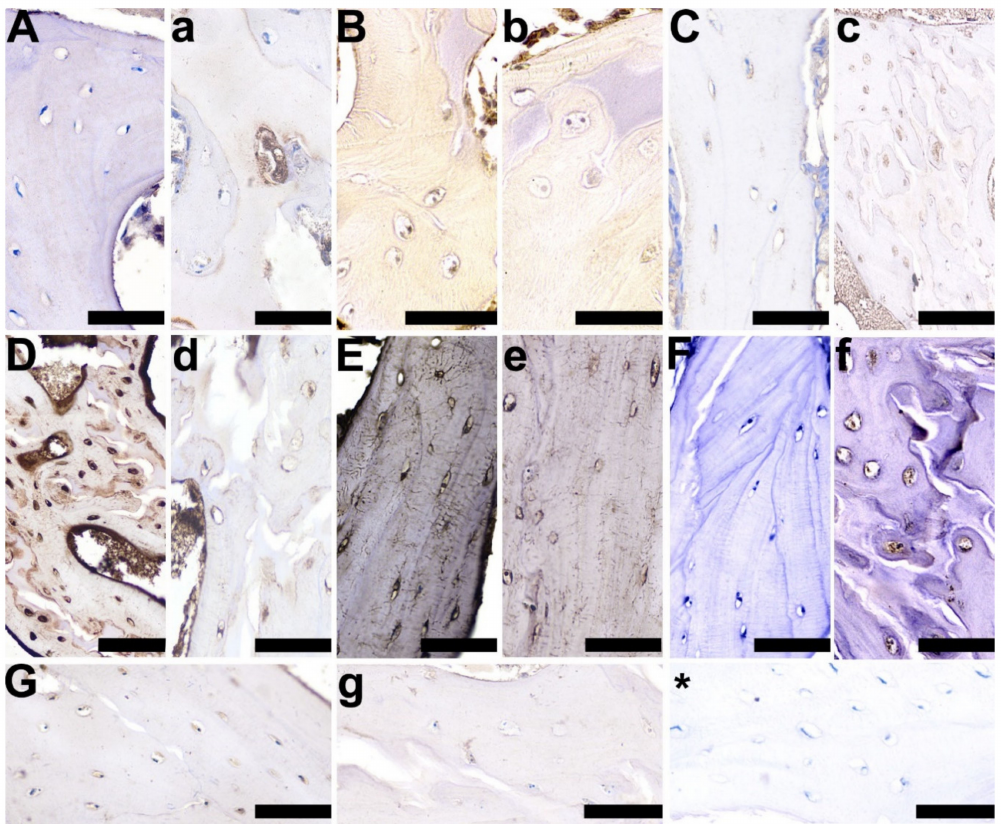
Figure 7. Representative pictures of the immunohistochemical analysis of bone morphogenetic protein 2, BMP-2 ( A , a ); glucocorticoid receptors, GRs ( B , b ); osteoprotegerin, OPG ( C , c ); receptor activator of nuclear factor kappa-B ligand, RANKL ( D , d ); tissue inhibitor of metalloproteinases 2, TIMP-2 ( E , e ); osteocalcin, OC ( F , f ); and vascular endothelial growth factor, VEGF ( G , g ), carried out on formaldehyde-fixed sections from the femoral trabeculae of gilts from the control group (growth-retarded gilts not supplemented with 2-Ox ( A – G )) and the 2-Ox group (growth-retarded gilts supplemented with 2-Ox at a dose of 0.4 g / kg b.w. / day ( a – g )). Negative protein expression is represented by blue staining of the cytoplasm in the chondrocytes, while positive protein expression is represented by brown staining in the cells. Additionally, proteins (BMP-2, OC, RANKL, VEGF) secreted and released into the matrix are also stained in a brown color. (*)—anti-body control reaction. Each scale bar shows 50 µ